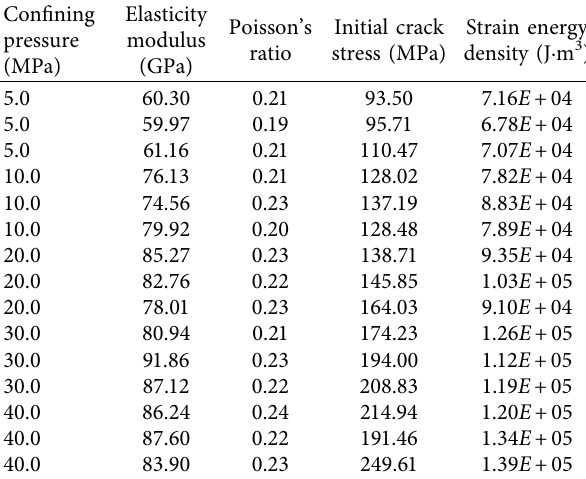
Table 1: The testing data and linear elastic strain energy.